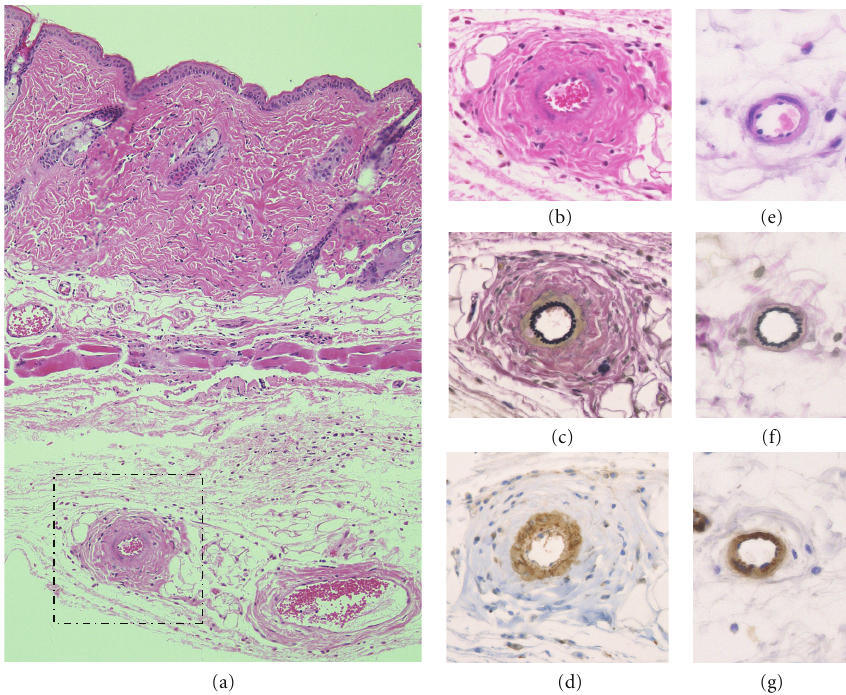
Figure 1: (a) Sclerotic skin induced by bleomycin injection. (b) Close-up view of the vascular lesions showing thickened wall. (c) Elastica van Gieson (EVG) stain showing proliferation of arterial intima. (d) α -SMA stain showing proliferation of vascular smooth muscle cells. (e)–(g) Vascular features of control mice treated with PBS were shown (e; H-E, f; EVG, g; α -SMA